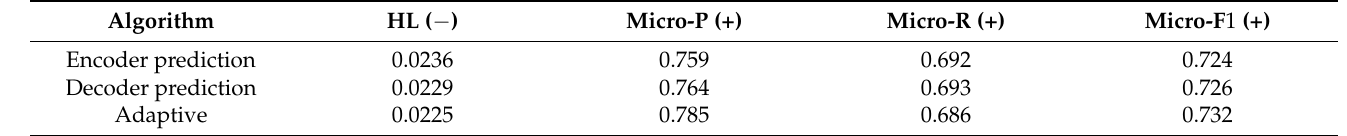
Table 5. Ablation experiment